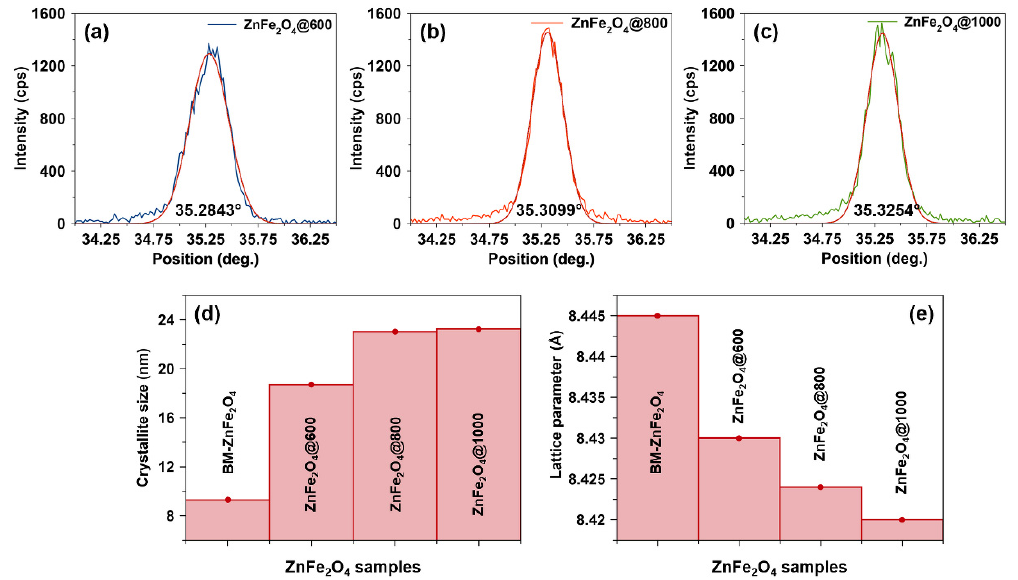
Figure 3. The characteristic (311) plane diffractions of cubic spinel ZnFe 2 O 4 nanoparticles annealed at ( a ) 600, ( b ) 800, and ( c ) 1000 °C. ( d ) The crystallite size, and ( e ) lattice parameter of ZnFe 2 O 4 nanoparticles as a function of annealing temperature.